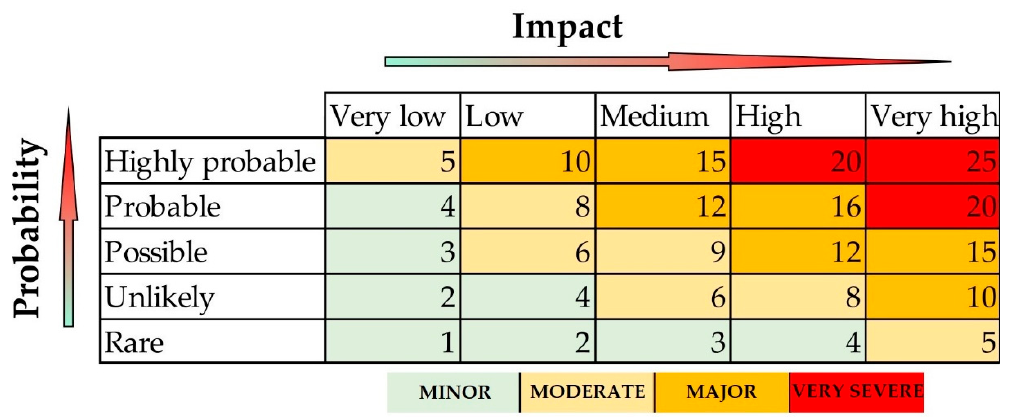
Figure 3. Semiquantitative 5 × 5 risk assessment matrix ([54,55], modified).